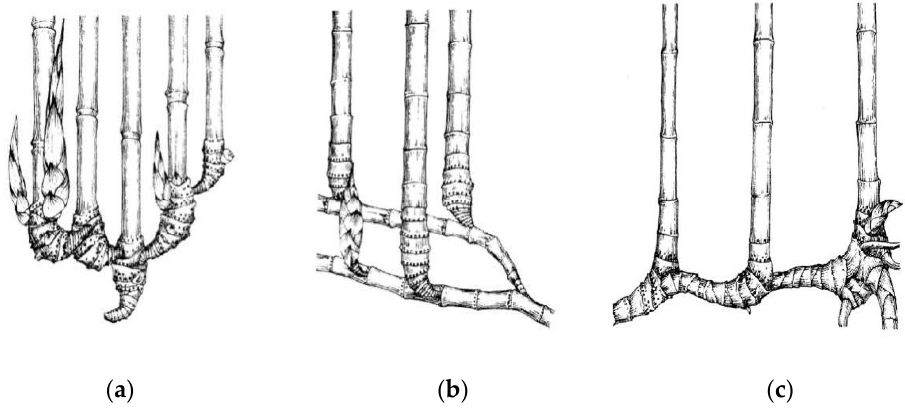
Figure 1. Three typical bamboo types [1]. ( a ) Sympodial rhizomes with caespitose culms. ( b ) Sympodial rhizomes with scattered culms. ( c ) Monopodial rhizomes with scattered culms.